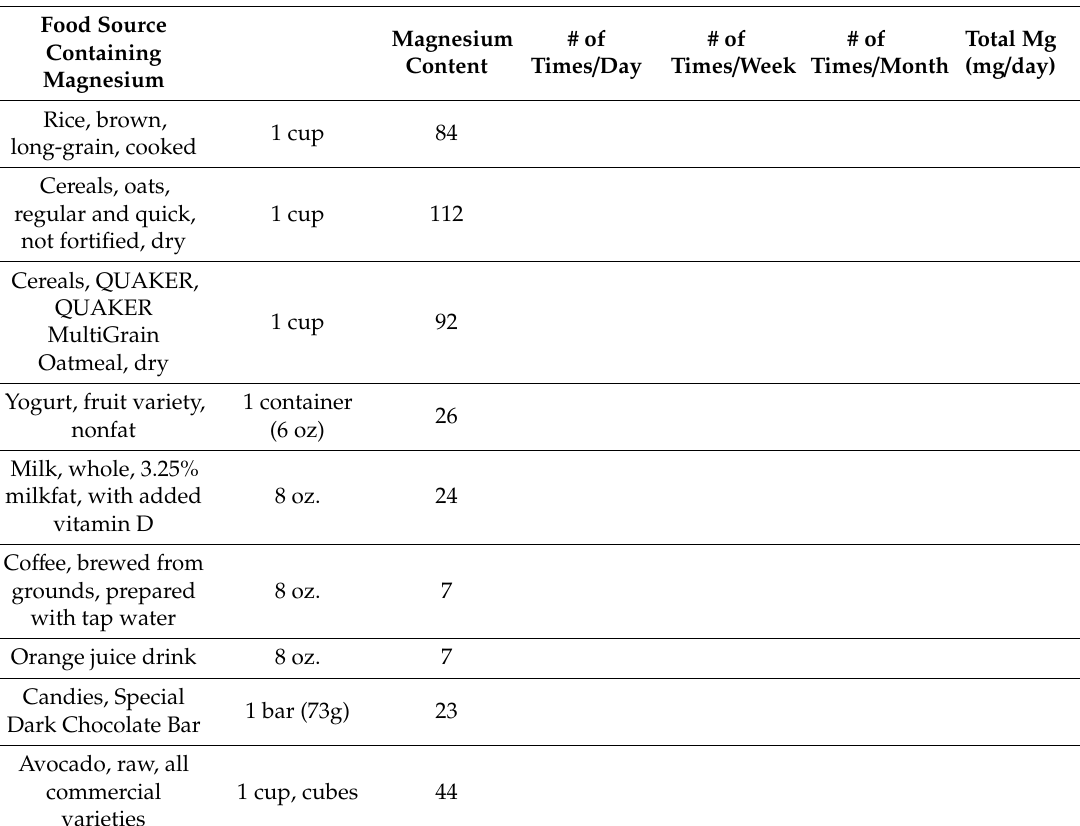
Table A1. Cont. How Often Do You Eat or Drink This Food or Beverage?